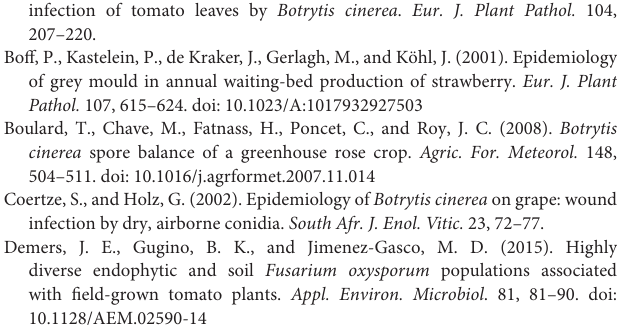
Figure S1 | Phylogenetic position of 47 Botrytis isolates from asymptomatic dandelion (labeled by DAN and a number) in the genus based on HSP60 sequences. Sequences of recognized Botrytis species are taken from Hyde et al. (2014), sequences from B. mali were determined by O’Gorman et al. (2008), the sequence of isolate BOT079 was determined by Shipunov et al. (2008). Phylogenetic tree construction used a maximum likelihood method with 1000 bootstraps. Only bootstrap values higher than 50% are displayed at the nodes. Figure S2 | Phylogenetic position of 47 Botrytis isolates from asymptomatic dandelion (labeled by DAN and a number) in the genus based on G3PDH sequences. Sequences of recognized Botrytis species are taken from Hyde et al. (2014), sequences from B. mali were determined by O’Gorman et al. (2008). Phylogenetic tree construction used a maximum likelihood method with 1000 bootstraps. Only bootstrap values higher than 50% are displayed at the nodes. Figure S3 | Phylogenetic position of 13 Botrytis isolates from asymptomatic dandelion (labeled by DAN and a number) in the genus based on RPB2 sequences. Sequences of recognized Botrytis species are taken from Hyde et al. (2014), sequences from B. mali were determined by O’Gorman et al. (2008). Phylogenetic tree construction used a maximum likelihood method with 1000 bootstraps. Only bootstrap values higher than 50% are displayed at the nodes. Figure S4 | Phylogenetic position of 16 Botrytis cinerea isolates from asymptomatic dandelion (labeled by DAN and a number) in the genus based on G3890 sequences. B. cinerea strain B05.10 serves as the reference and B. calthae strain MUCL2830 was used as an outgroup. Phylogenetic tree construction used a maximum likelihood method with 1000 bootstraps. Only bootstrap values higher than 50% are displayed at the nodes. Figure S5 | Phylogenetic position of 16 Botrytis cinerea isolates from asymptomatic dandelion (labeled by DAN and a number) in the genus based on FG1020 sequences. Sequences from B. cinerea strain B05.10 and B. pseudocinerea strain VD110 (determined by Leroch et al., 2013) serve as the reference while B. calthae strain MUCL2830 was used as an outgroup. Phylogenetic tree construction used a maximum likelihood method with 1000 bootstraps. Only bootstrap values higher than 50% are displayed at the nodes. Figure S6 | Phylogenetic position of 14 Botrytis isolates from asymptomatic dandelion (labeled by DAN and a number) in the genus based on MRR1 sequences. Sequences from B. cinerea strain B05.10, Botrytis N11SE08 and B. pseudocinerea strain VD256 (determined by Leroch et al., 2013) serve as the references. Phylogenetic tree construction used a maximum likelihood method with 1000 bootstraps. Only bootstrap values higher than 50% are displayed at the nodes. Table S1 | Sequences of primers used in this